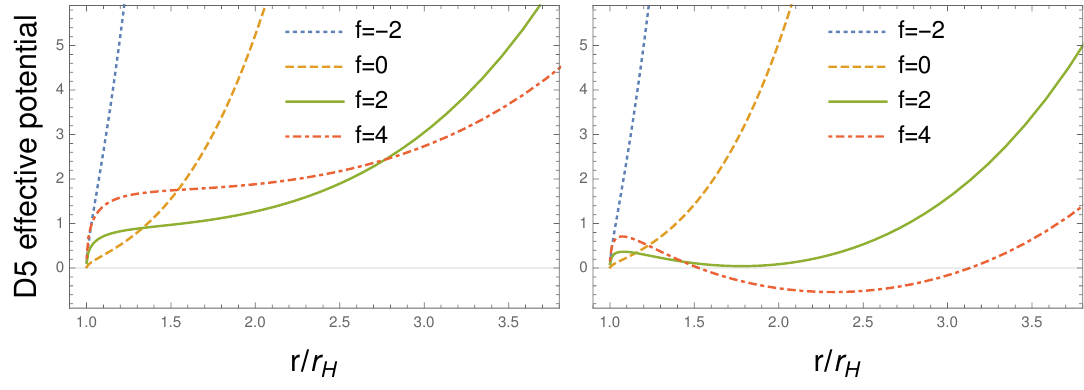
Figure 6 . The e(cid:11)ective potential for a probe D5-brane, with J = 0 and varying the worldvolume (cid:13)ux, in backgrounds with T=M = 0 : 5. On the left, T=(cid:22) B = 0 : 5, which is outside the region where the nucleation instability occurs | thus no minimum forms as the (cid:13)ux is increased. On the right, we are inside the unstable region with T=(cid:22) B = 0 : 1 | increasing the (cid:13)ux then leads to the formation of a